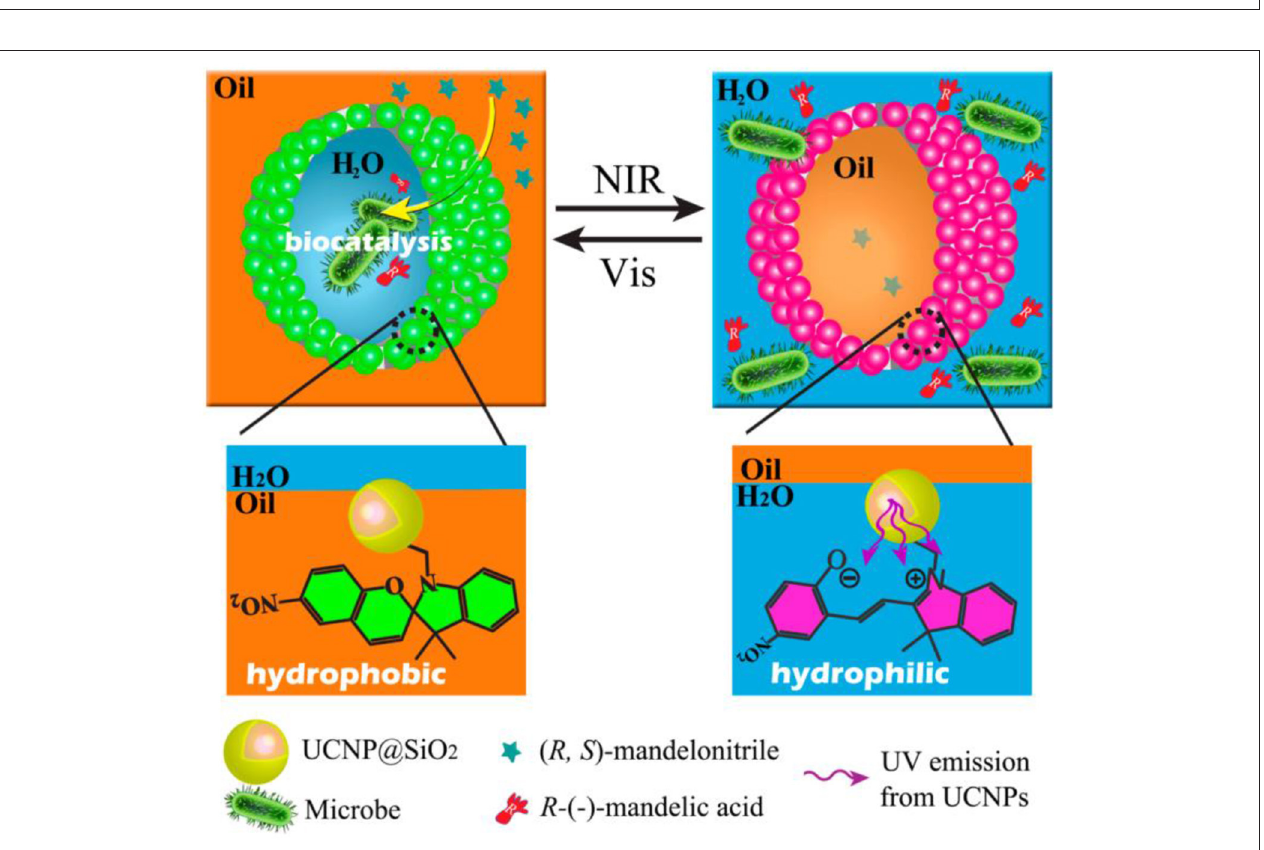
FIGURE 7 | Schematic representation of NIR/visible light controlled Pickering emulsions for biphasec enantioselective biocatalysis (Chen et al., 2014). Reprinted with permission from Chen et al. (2014). Copyright 2014 American Chemical